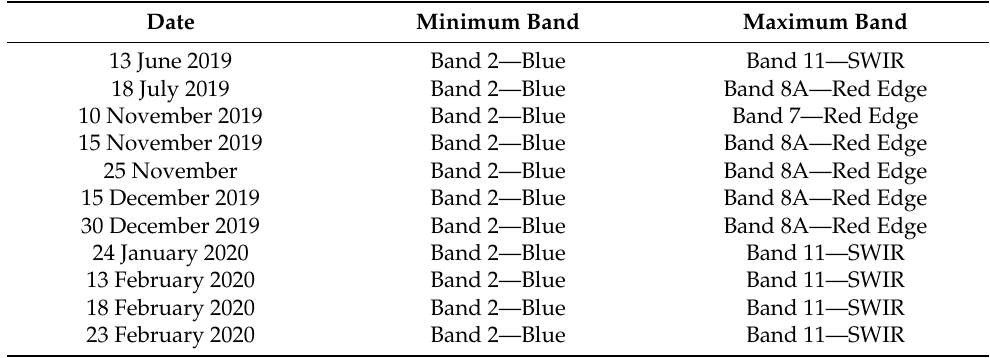
Table 3. CBSI-MSAVI2—Maximum and Minimum Reflectance Bands for Temporal indices that ensure maximum enhancement of the target Pigeon Pea crop class.